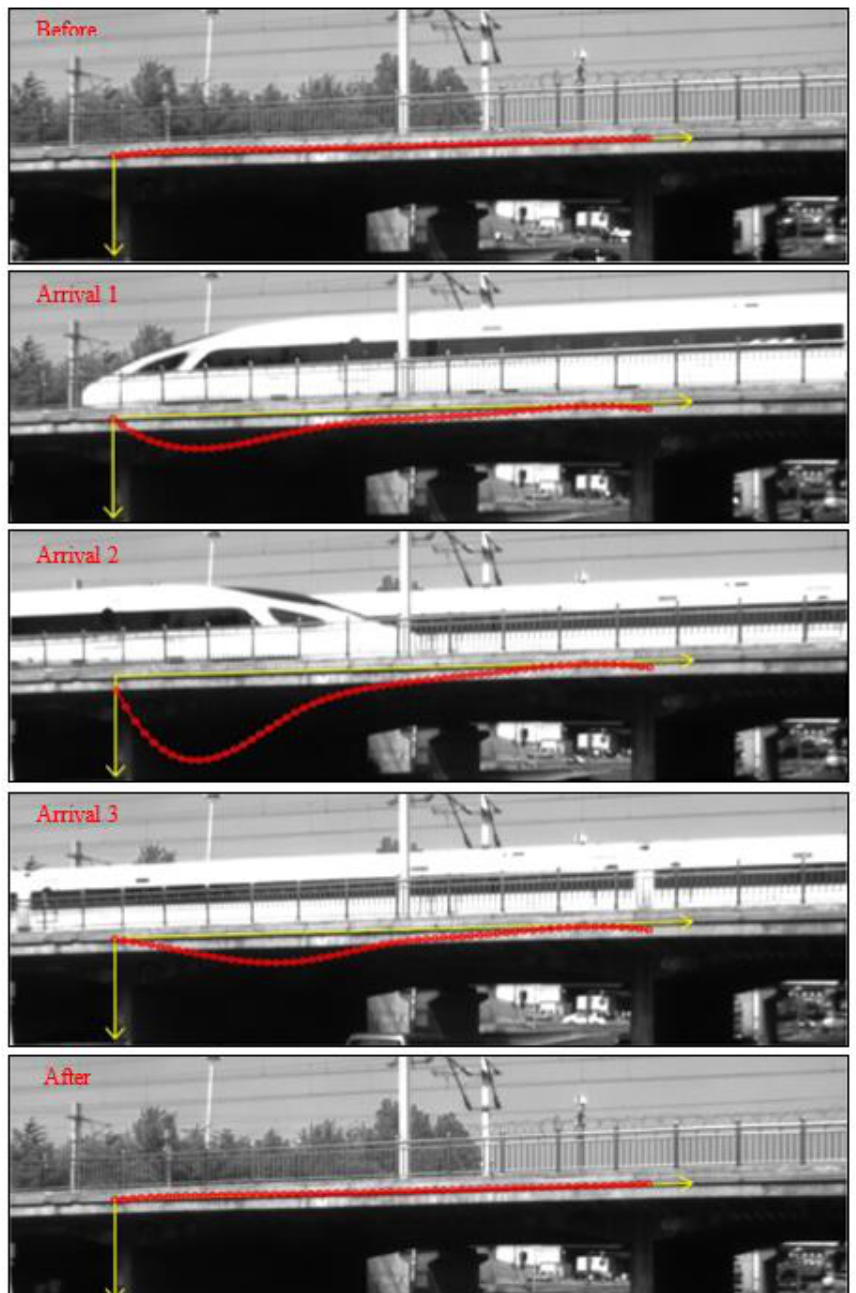
Figure 12. Full-field bridge deflection curves at five representative moments.